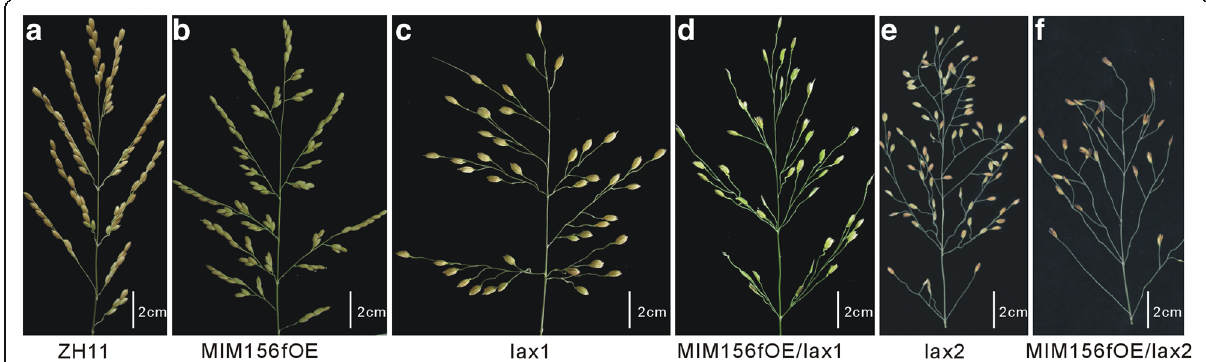
Fig. 2 Panicle phenotype of the MIM156fOE/lax1 hybrid and the MIM156fOE/lax2 hybrid. a ZH11, b MIM156fOE, c lax1 , d MIM156fOE /lax1 , e lax2 ,